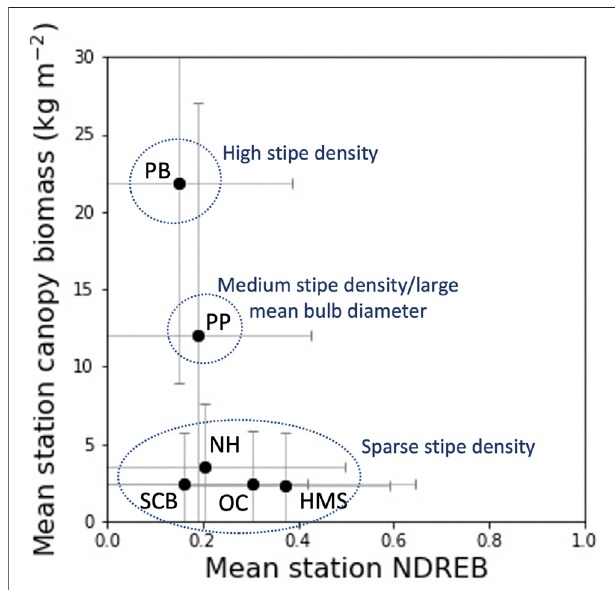
FIGURE 8 | Mean station canopy biomass plotted again mean station NDREB with ± 1SE bars in grey. Different circles represent conditions of stipe density at the different dive